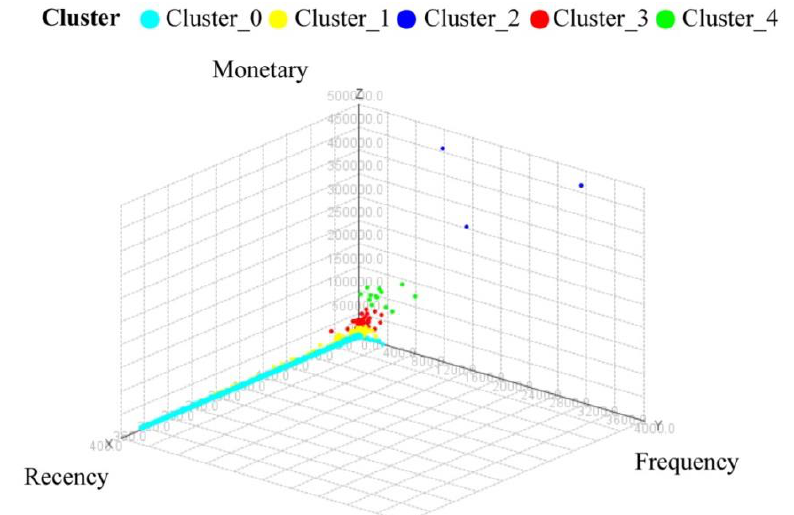
Figure 5. 3D scatter plot of RFM variables of clothes shipper clusters.